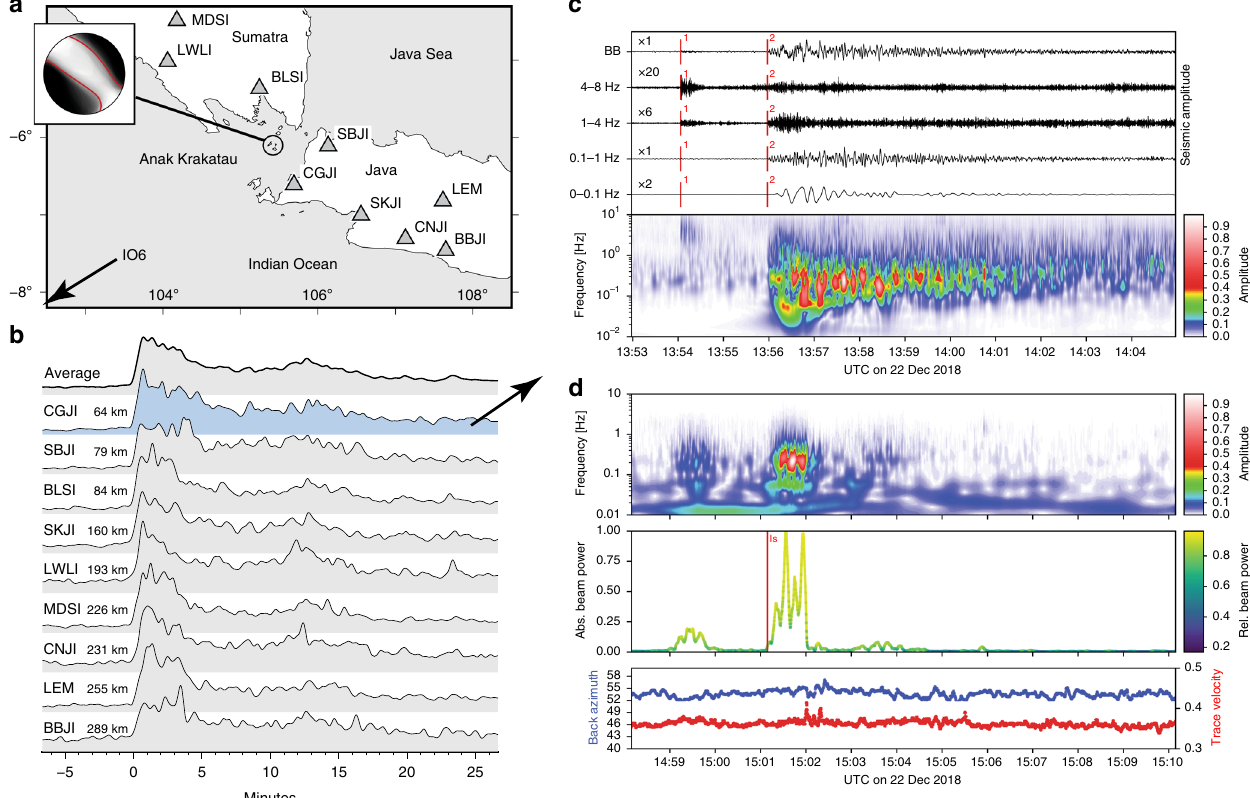
Fig. 4 Seismic and infrasound recordings of the Anak Krakatau sector collapse. a Locations of stations with regional seismic instruments. Station I06AU is an infrasound station located 1150 km to the SW of Krakatau (beyond the edge of the map). The inset shows the probabilistic moment tensor solution with the best nodal plane striking NW – SE and dipping to the SW and a large compensated linear vector dipole (CLVD) component. The red line indicates the nodal surface of the best double couple component from the full moment tensor solution. b Smoothed envelopes of vertical component 0.4 – 1 Hz bandpass- fi ltered seismic records. c Normalized seismic amplitudes at the closest station (CGJI), located 64 km from Anak Krakatau, revealing the occurrence of a high-frequency event (1) 115 s prior to the sector collapse (2). The spectrogram reveals that collapse is a 1 – 2-minute-long low-frequency signal presumably related to the landslide, followed by ~5 mins of strong emissions at high frequencies. d Upper and middle panels: Infrasonic spectrograms of the best beam and beam power from the seven-element infrasound array at I06AU, where the onset of a strong impulsive signal was registered at 15:01:09. The beam direction and trace velocity, displayed in the lowermost panel, point towards Krakatau (back azimuth 55 – 56°, compared with Supplementary Figure 8) with a trace velocity of ~60 m s − 1 . Although the strong impulsive signal (the landslide) spanned a duration of only ~1 min, in the time window shown in the fi gure, the beam focuses continuously towards Krakatau, indicating continuous energy fl ow from Krakatau for a much longer time span (see also Supplementary Figure 8). The red mark (labeled Is ) shows the theoretical arrival time of the stratospheric phase predicted by infrasound modeling,